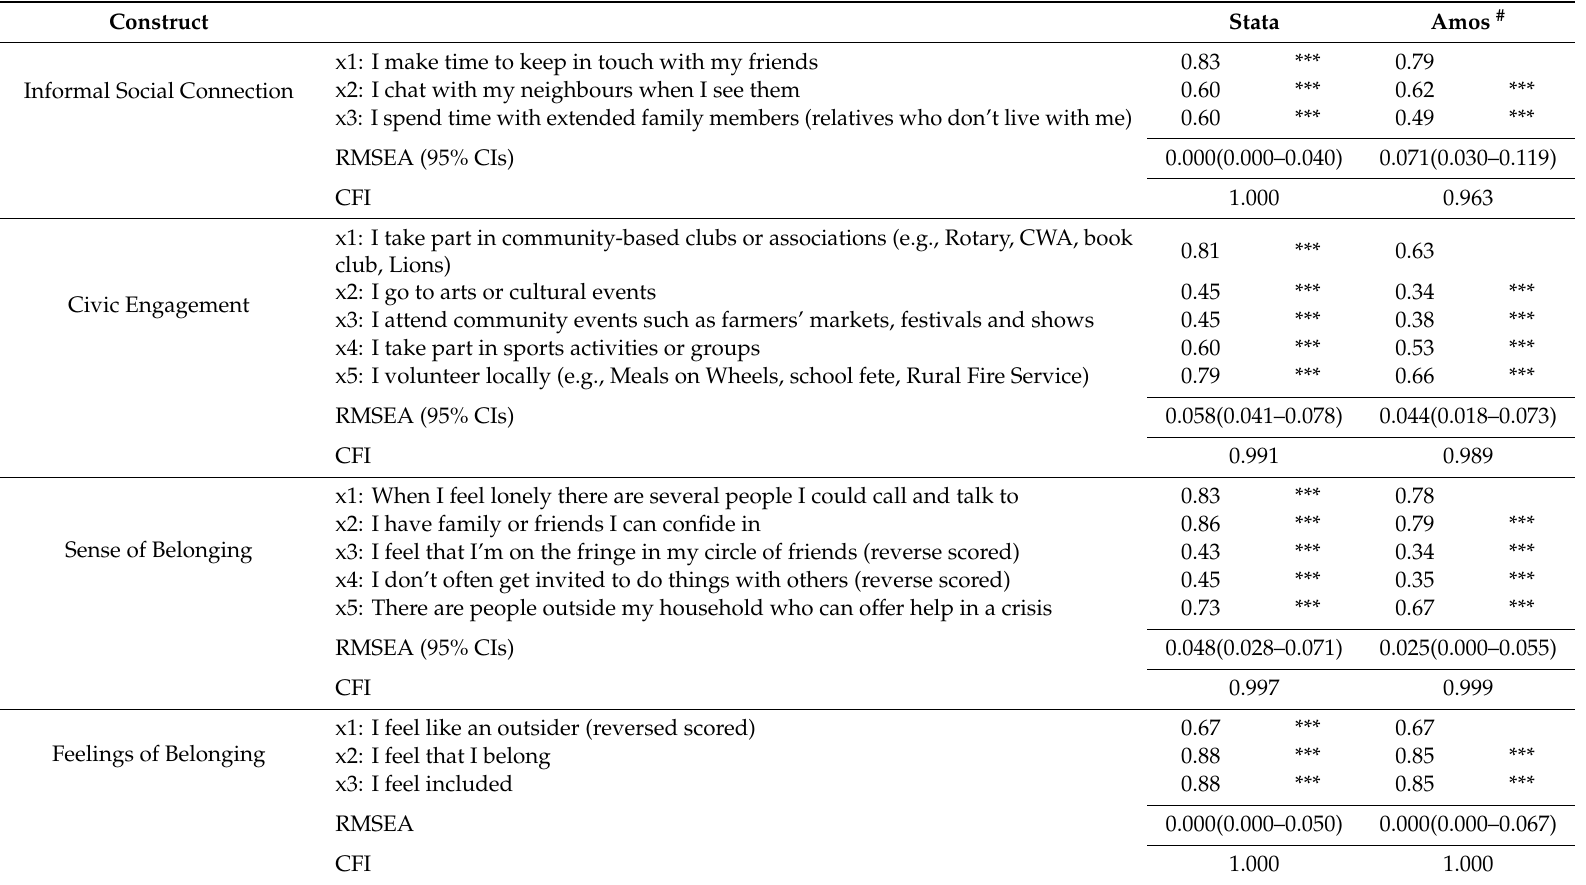
Table A1. Comparison of CFA standardised factor loadings and model fit indices in Stata15 and Amos 25. Construct Stata Amos # Informal Social